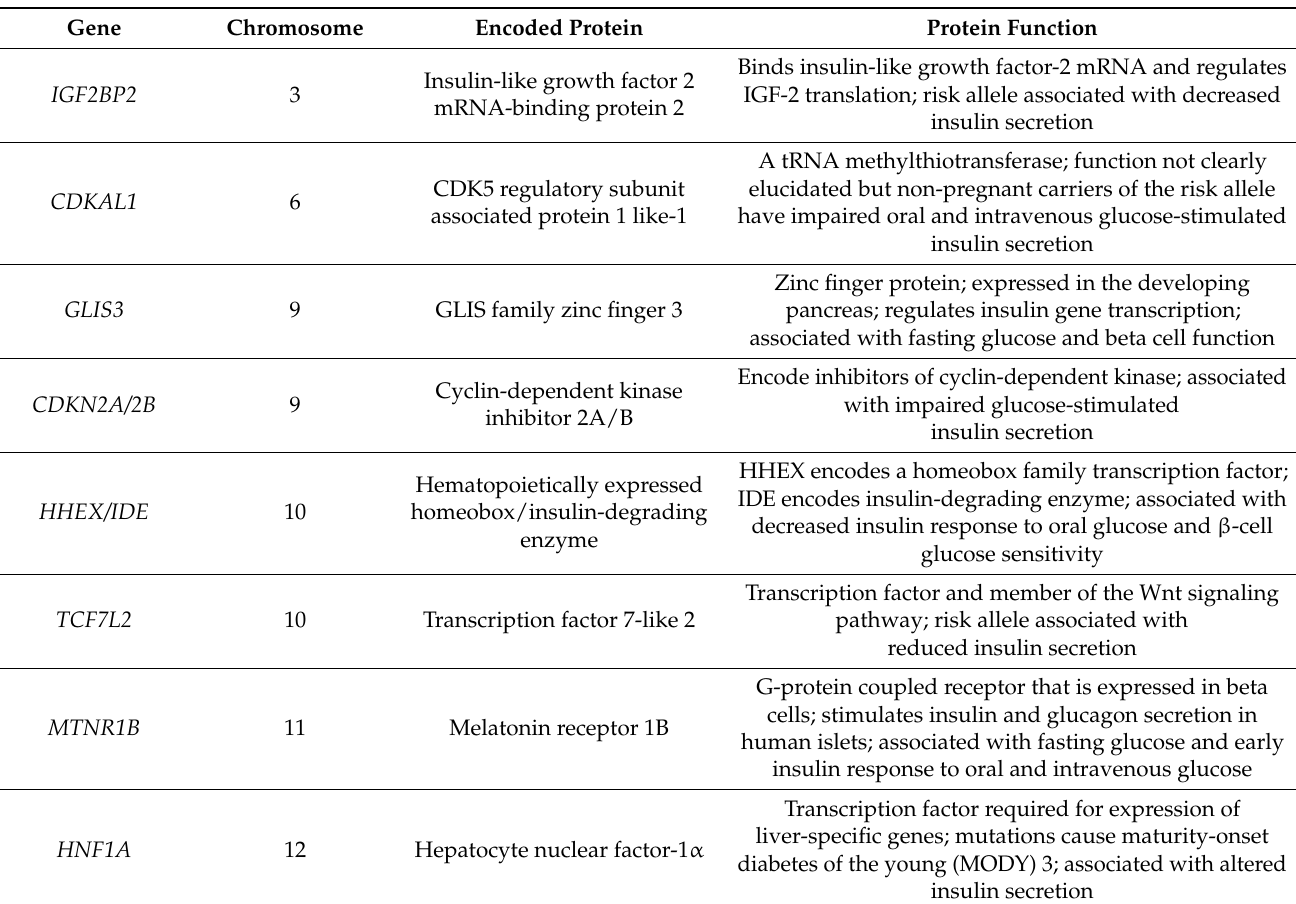
Table 1. Genetic loci associated with GDM in recent